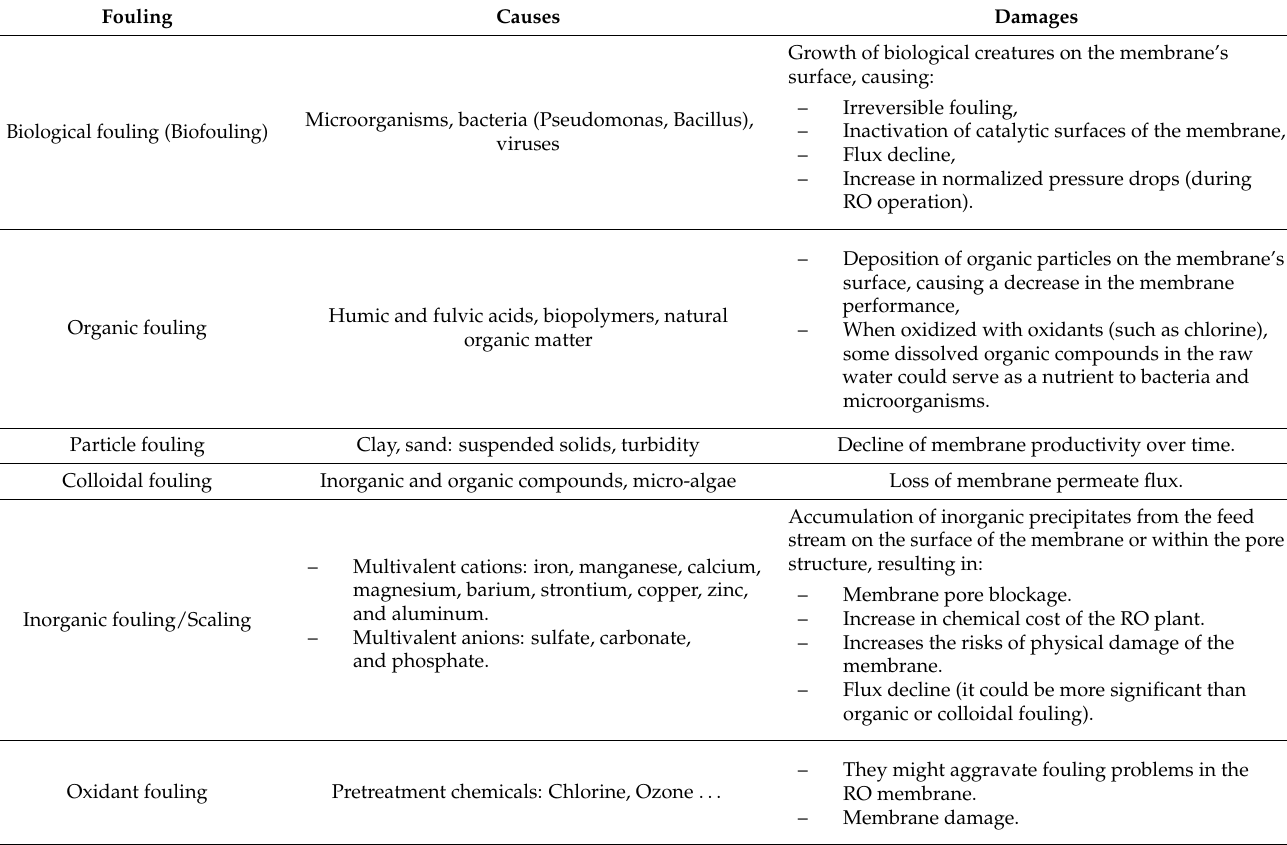
Table 3. Major foulants impacting the performance of SWRO systems